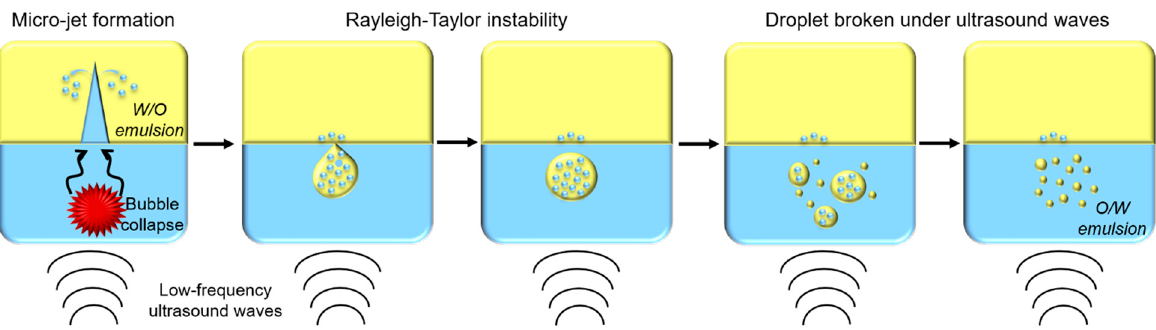
Figure 4. Schematic representation of cavitation phenomenon under low-frequency ultrasounds treatment.